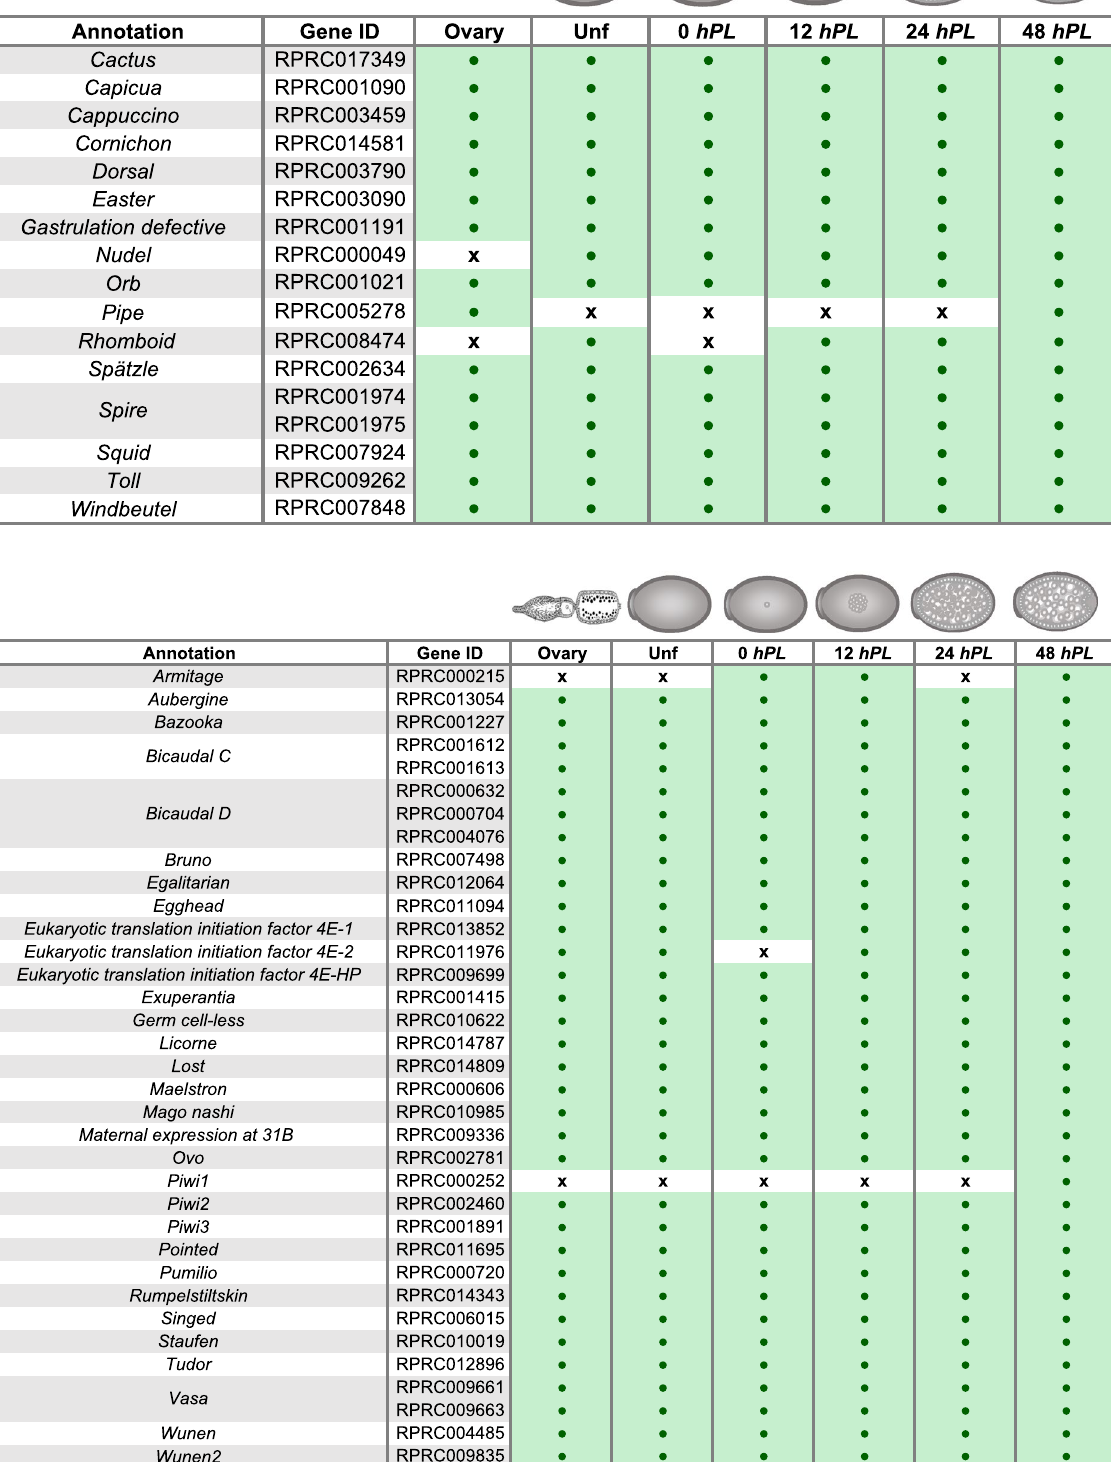
Table 3. Developmental genes identified in the R. prolixus transcriptomes. Gene ID: VectorBase code (the official gene number in the RproC3 genome assembly); Annotations: protein name we are assigning. For each annotation, presence/absence was assessed by sequence similarity search. Green boxes indicate presence of expression; white boxes indicate absence of expression. A: Segmentation genes, B: Dorso-ventral genes, C: oogenesis, orthologues piwi genes were annotated as Brito, et al. 48